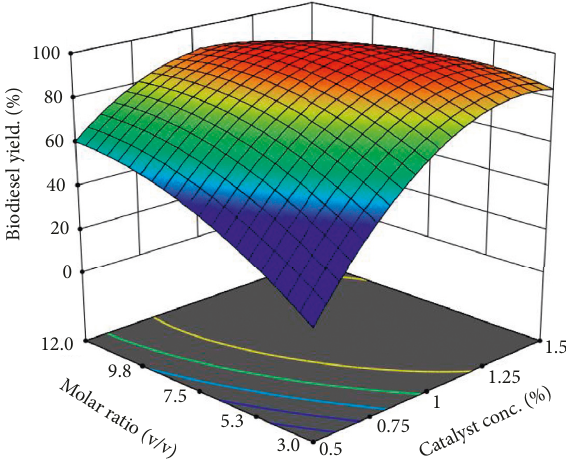
Figure 2: Effect of ethanol to mixed oil molar ratio and catalyst concentration on the yield of biodiesel at a reaction temperature of 50 ° C.